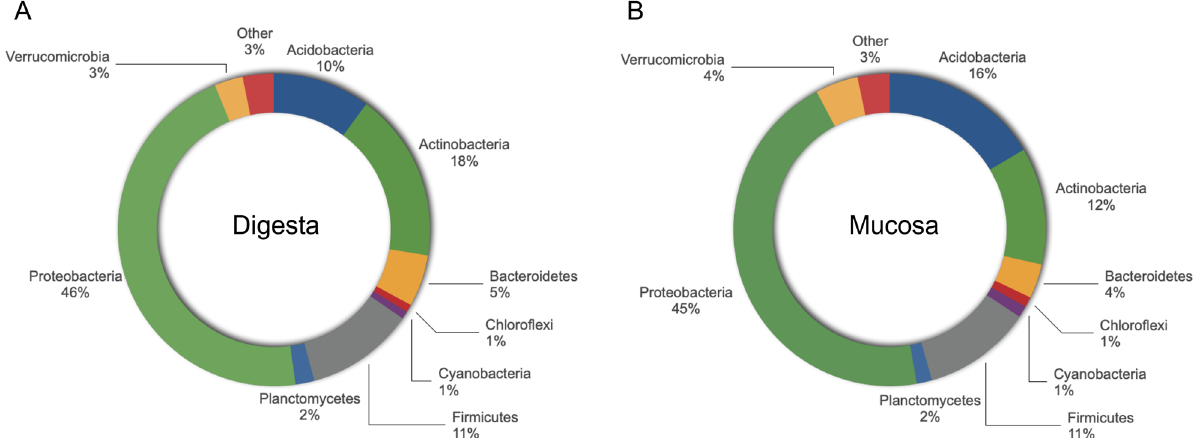
Figure 1. Bacterial phyla diversity obtained from digesta ( A ) and mucosa ( B ) samples of European sea bass fed the experimental diets for 45 days, after NGS analysis by Illumina MiSeq. There are no significant differences between both intestinal compartments, although the Acidobacteria are more abundant at the mucosal level while the Actinobacteria show higher values at the luminal level.